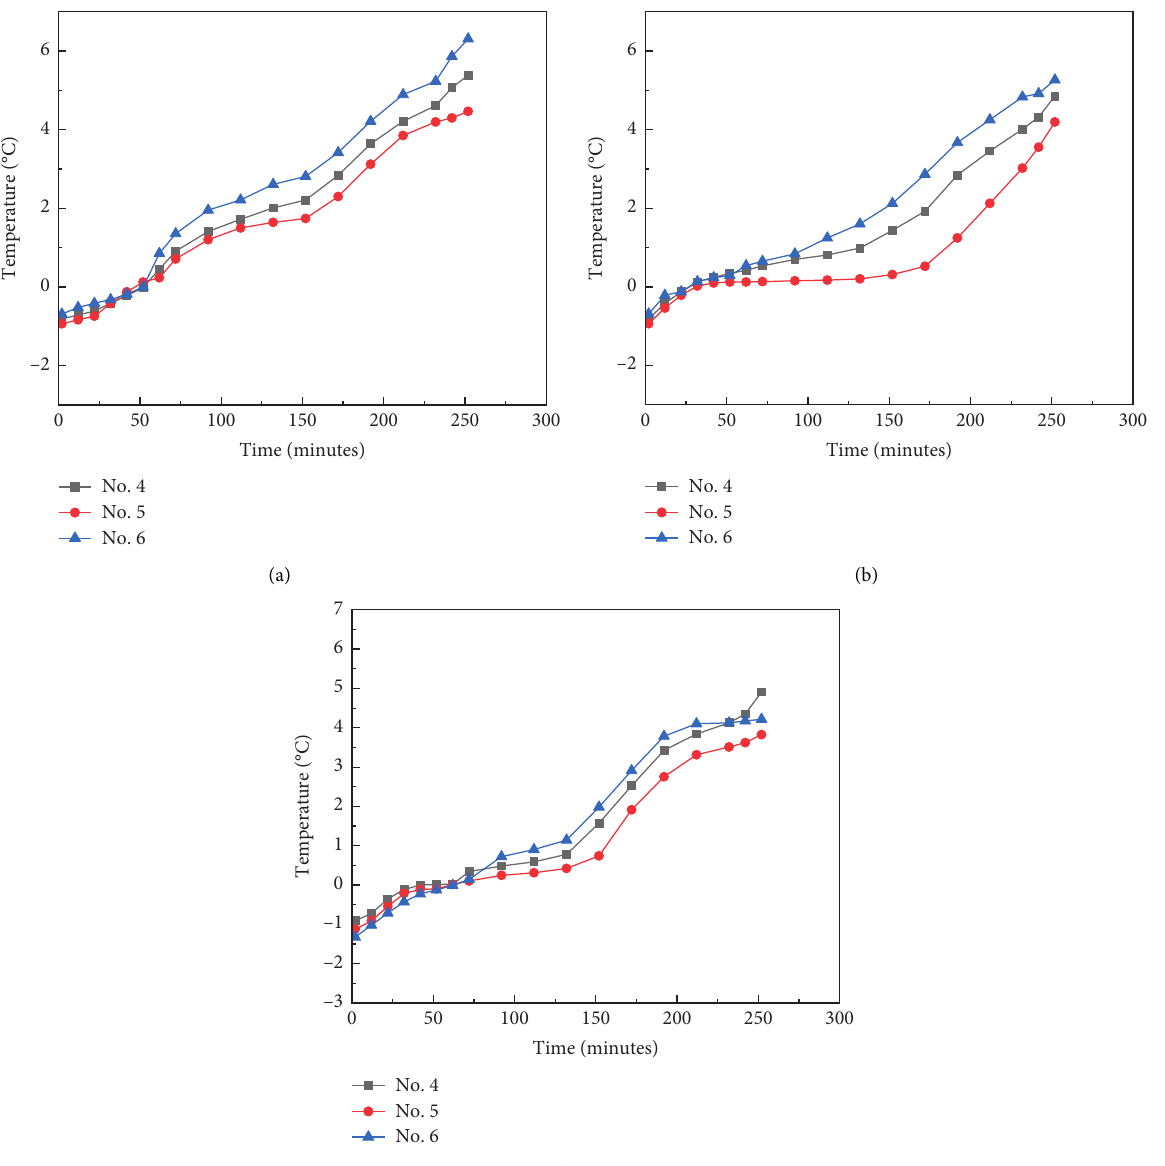
Figure 12: Temperature change curves of measuring points Nos. 4, 5, and 6 under various working conditions of ice melting experiment: (a) − 2 ° C; (b) − 4 ° C; (c) − 8 ° C. Table 7: Temperature change rate of the first layer’s measurement points Nos. 4, 5, and 6 of the ice melting experiment. − 2 −